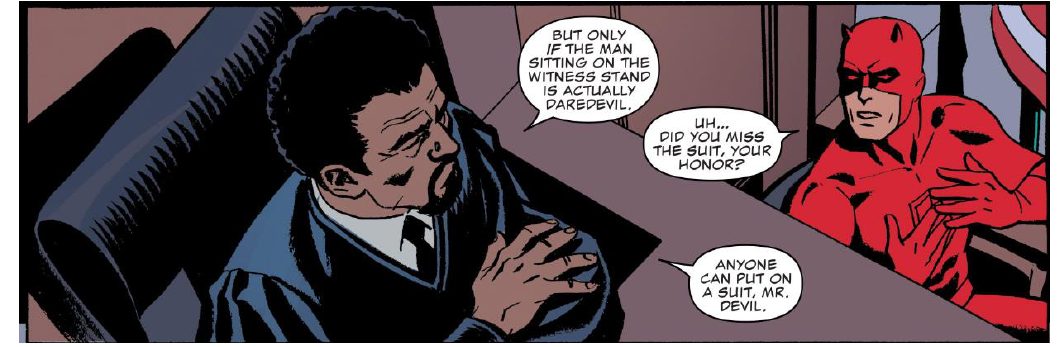
Figure 4. Panel from Soule’s Daredevil: Back in Black Vol. 5: Supreme #21, 2017. Image Credit: Goran Sudžuka © 2017 Marvel Characters,